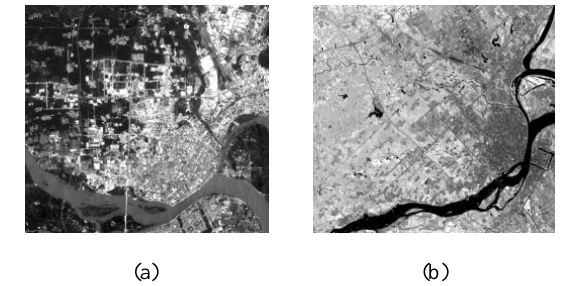
Figure 1. Multimodal images with overlap regions. (a) is a visible band image. (b) is a near-infrared band image. There are significant geometric (scale and rotation) and non-linear radiometric distortion between the two